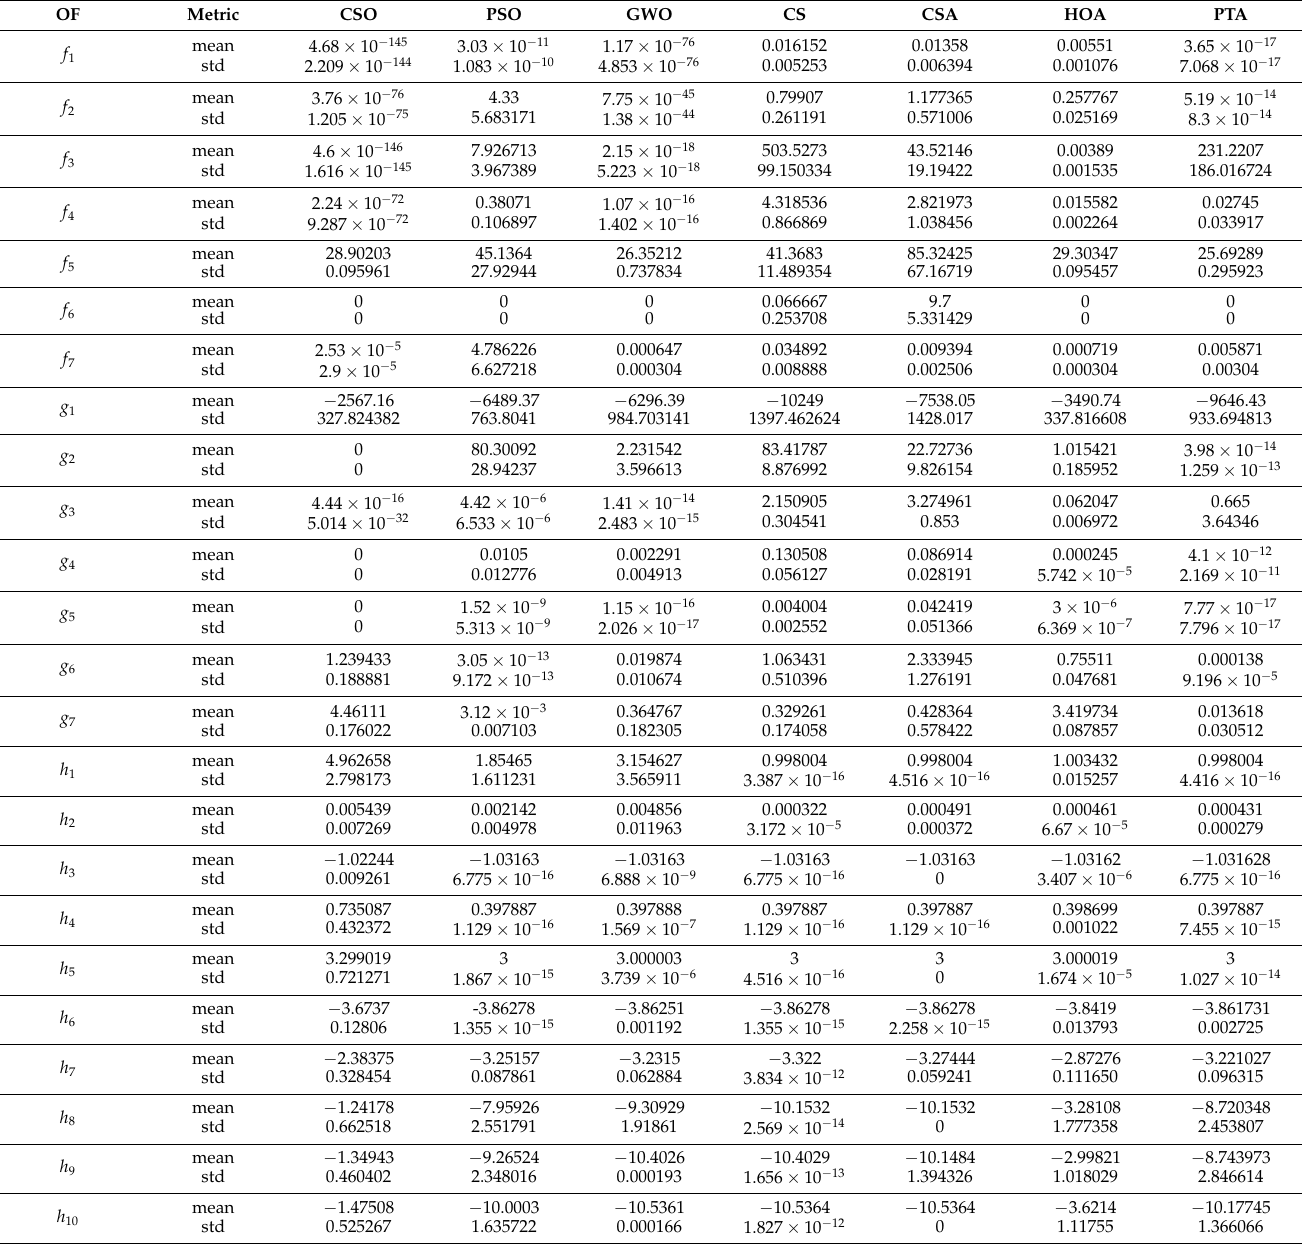
Table 6. Mean and Standard Deviation Results Summary.